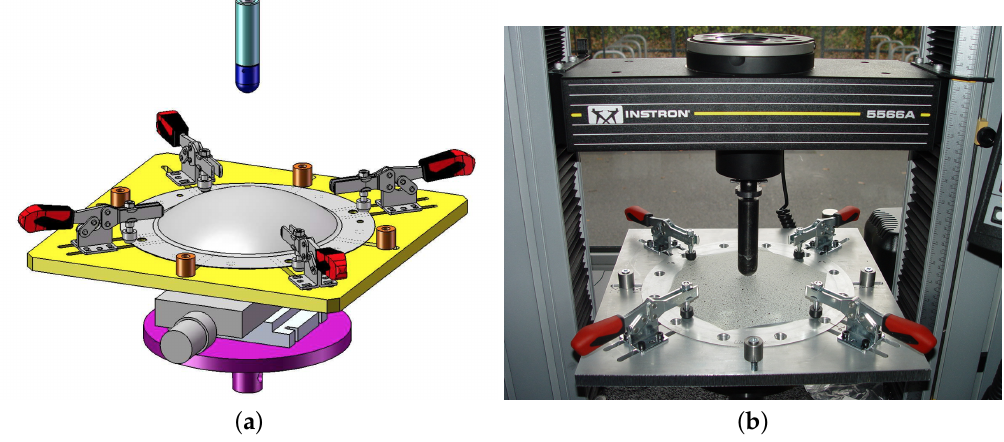
Figure 4. Device designed to characterise the dent resistance. ( a ) Schematic representation of dent test; ( b ) Experimental setup and sample.